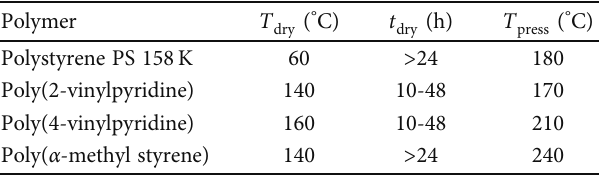
Table 2: Drying temperature T temperature of compression moulding T this